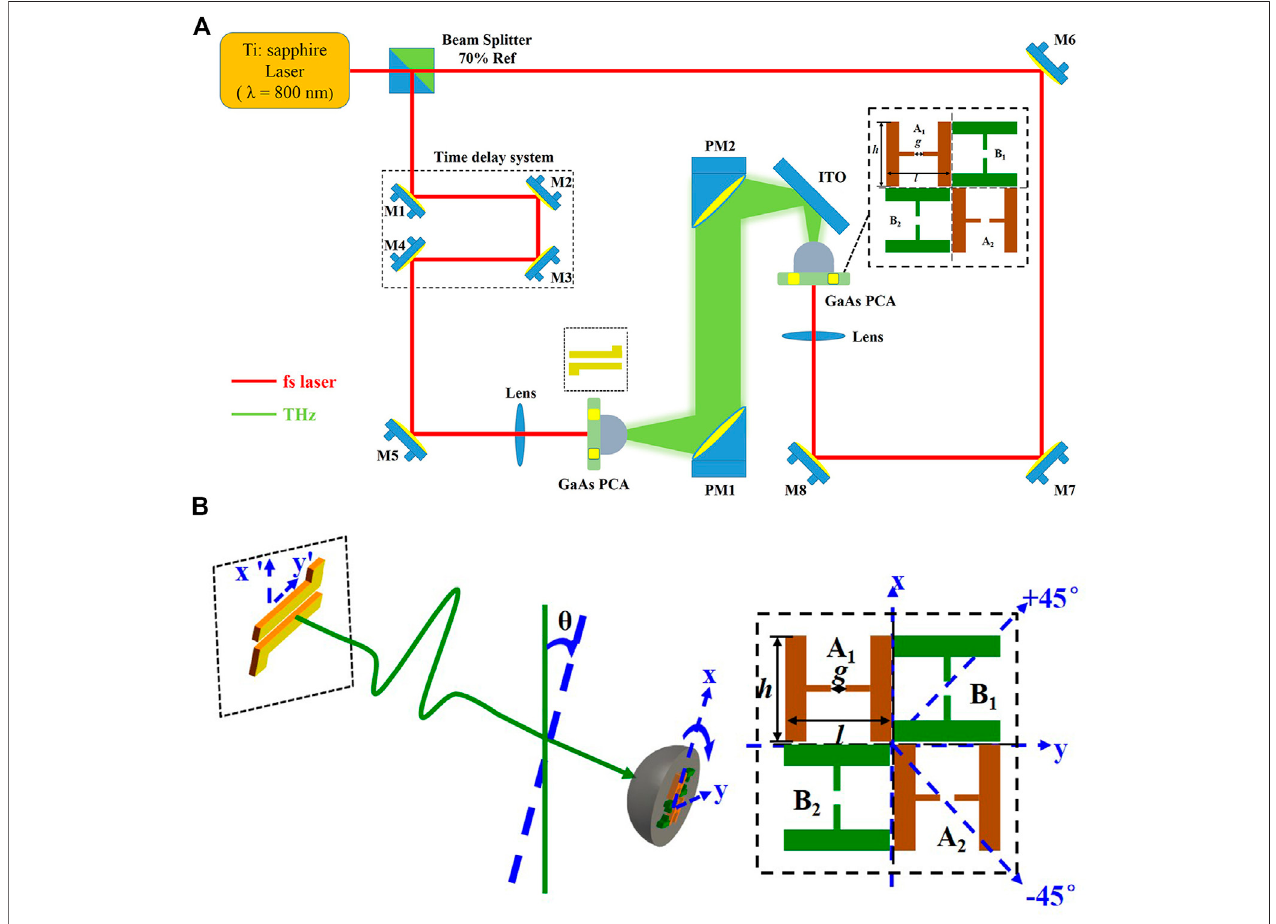
FIGURE 1 | (A) THz-TDS system and photoconductive antenna array detector structure for polarization detection and (B) Schematic diagram of antenna array detector ’ s rotation.